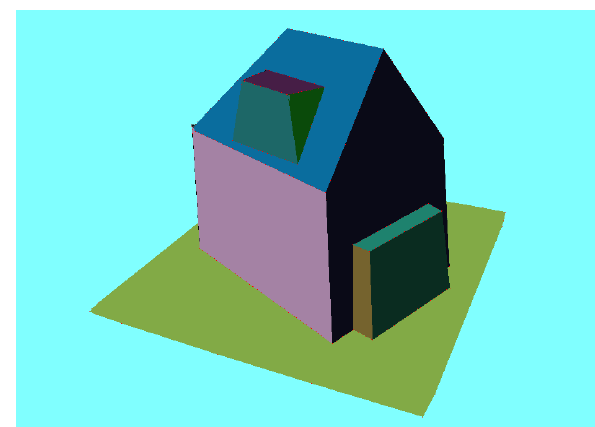
Figure 6. Result of adjustment of the points on the intersection lines of the segmented TIN of Figure 5.